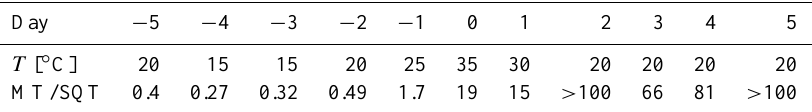
Table 2. Plant chamber temperatures and MT/SQT concentration ratios ([µgm − 3 ]/[µgm − 3 ]) during Experiment #2 with Norway spruce. Days relative to the day of heat stress application at day 0. Note that the needle temperature was about 4 ◦ C higher than the listed plant chamber temperature during periods of illumination (compare Kleist et al.,